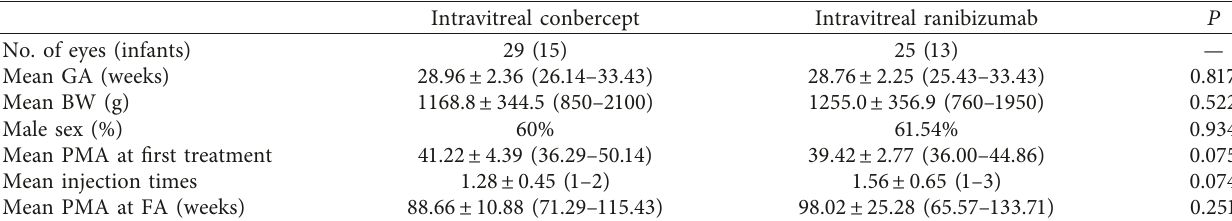
Table 1: Baseline characteristics of retinopathy of prematurity infants receiving intravitreal conbercept or ranibizumab. Intravitreal conbercept Intravitreal